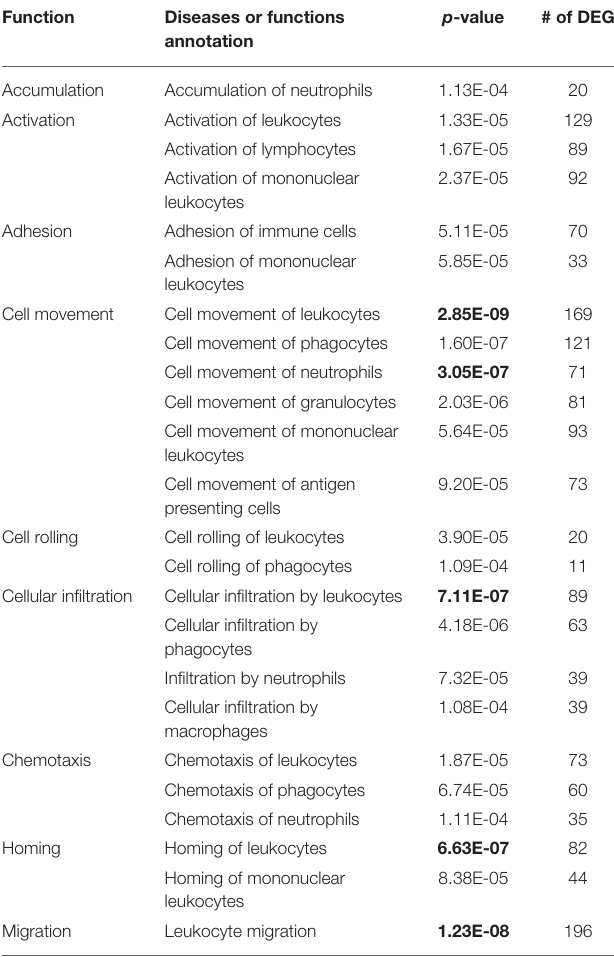
TABLE 1 | The p -values of the number (#) of differentially expressed genes (DEG) in 24 functions (top five with lowest p -value in bold fonts) of immune cell trafficking by random chances in the analyses of diseases and functions using Qiagen Ingenuity Pathway Analysis